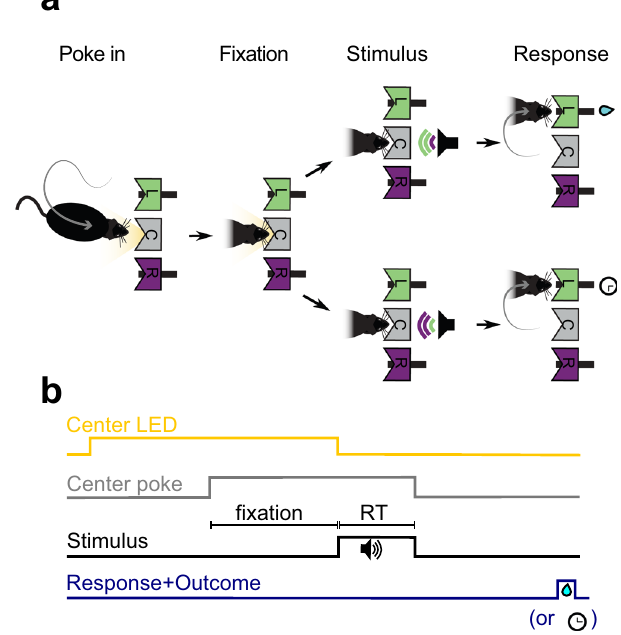
Fig. 1 Auditory discrimination task. a The initiation of each trial was cued by a center port LED (yellow). Following the cue, rats poked in the center port (C, gray) and the fi xation period (300 ms) started. At the end of the fi xation period, the stimulus was presented, consisting of a mixture of two AM sounds, each of which is associated with reward in the Left (L, green) or Right (R, purple) port. The two sounds differed in frequency (frequency discrimination task) or in the location of the sound source (lateralization discrimination task). After stimulus onset, the rats were free to withdraw from the center port to elicit a response, causing the stimulus to stop. Correct responses were rewarded with water and incorrect responses were punished by a time-out. b Task temporal scheme: reaction time (RT) denotes the time from stimulus onset to center poke